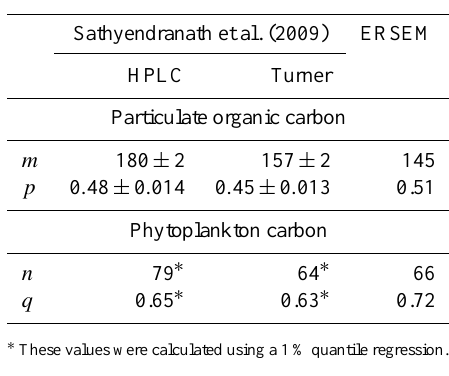
Table 3. Statistics to describe the POC:PON distribution as re- ported by Martiny et al. (2013), compared to the result of this study and to the canonical Redfield